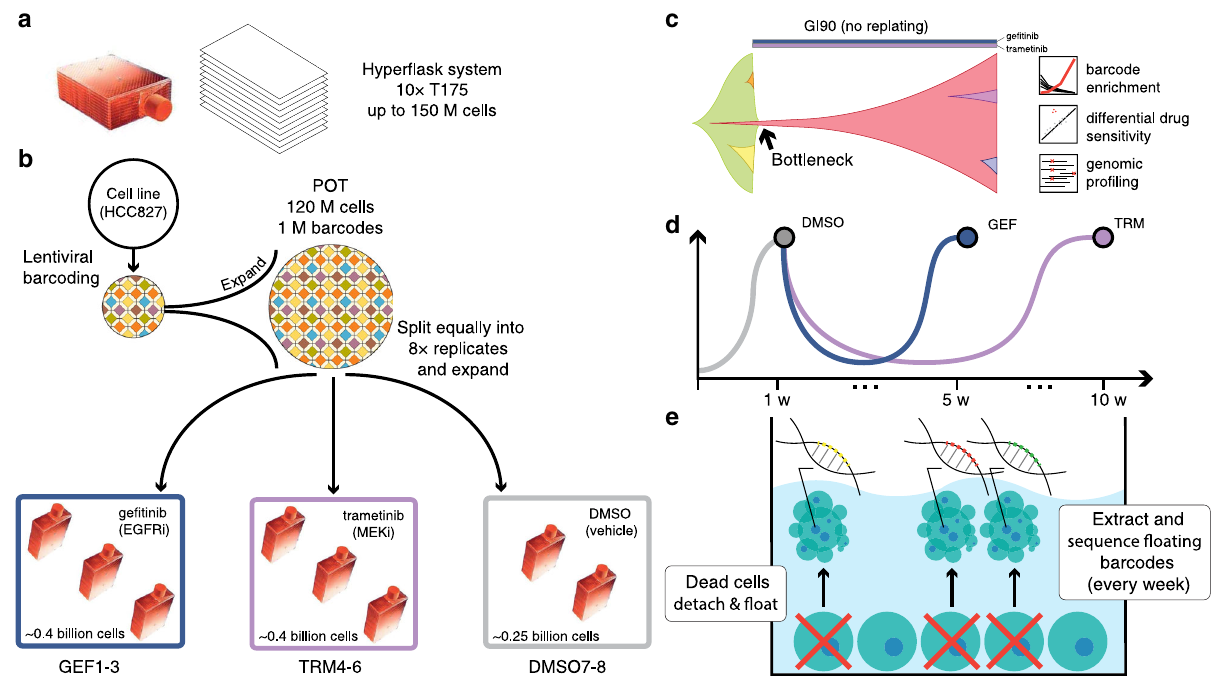
Fig. 2 Experimental design. a The Corning ® High Yield PERformance Flasks (HYPER fl ask ® ) cell culture vessel is a 10-layer 1720 cm 2 total growth area system with polystyrene gas permeable surface that can reach the order of 150 – 200 million cells. b One million HCC827 lung cancer cells were lentivirally barcoded before being expanded to a population (POT) of ~120 million cells in a HYPER fl ask. Eight replicates were seeded with ~12 million cells each and expanded to 120 million. The remaining POT cells are frozen for subsequent analysis. Of the eight seeded replicates, three are exposed to GI90 doses of ge fi tinib (GEF1 – 3), three to GI90 of trametinib (TRM4 – 6) and two were used as controls (DMSO7 – 8). c Clonal evolution of a large population containing pre-existing resistant subclones that is exposed to high drug concentration (GI90) without re-plating. A clonal bottleneck occurs by means of Darwinian selection for drug resistance. Barcode enrichment analysis, genomic pro fi ling and drug screening is performed on the resistant population. d Schematic growth curves for ge fi tinib (4 weeks for resistant population to regrow) and trametinib (9 weeks for the resistant population to regrow). Media and drug are changed weekly. e When cells die, they detach and fl oat in the media. At each media change (once per week), supernatant cells are harvested from the spent media and their DNA extracted for barcodes analysis and non-destructive tracking of tumour